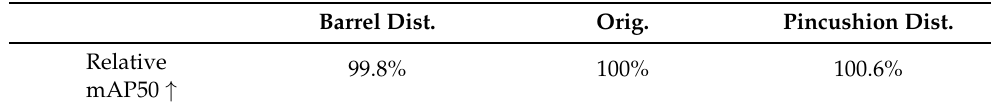
Table 2. Image Distortion: impact on the performance. Barrel Dist. Orig.